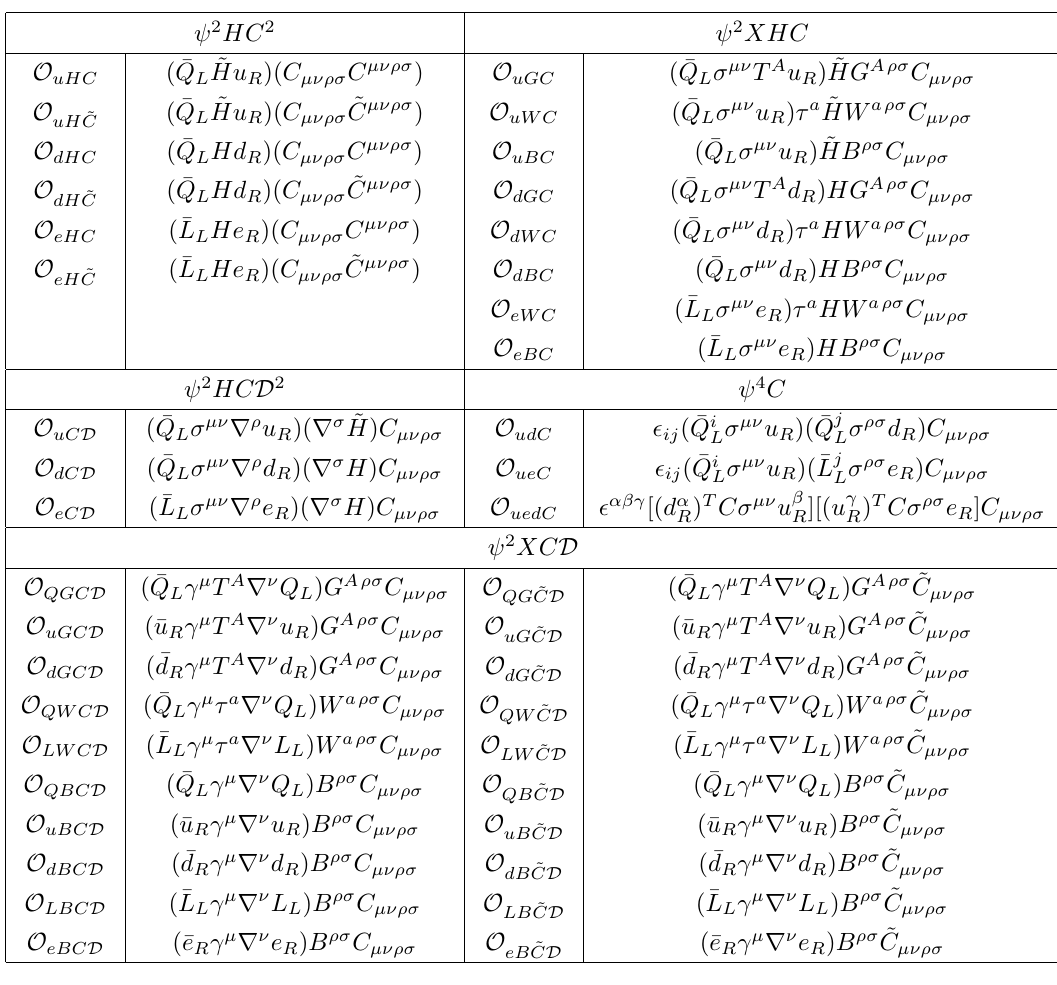
Table 4 . Dimension-8 operators of the GRSMEFT including gravitational interactions and fermions for N f = 1. We do not show explicitly the h.c. of non self-conjugate operators. ~ H i = (cid:15) ij H (cid:3) is the charge conjugation